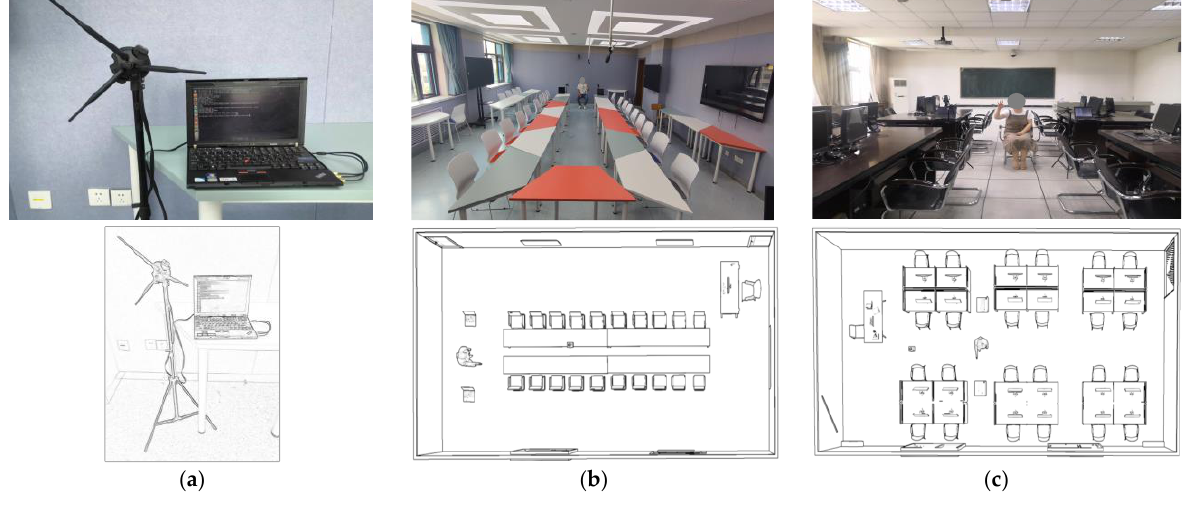
Figure 11. Experimental equipment and environment: ( a ) Experimental equipment. ( b ) Conference room environment. ( c ) Office environment.